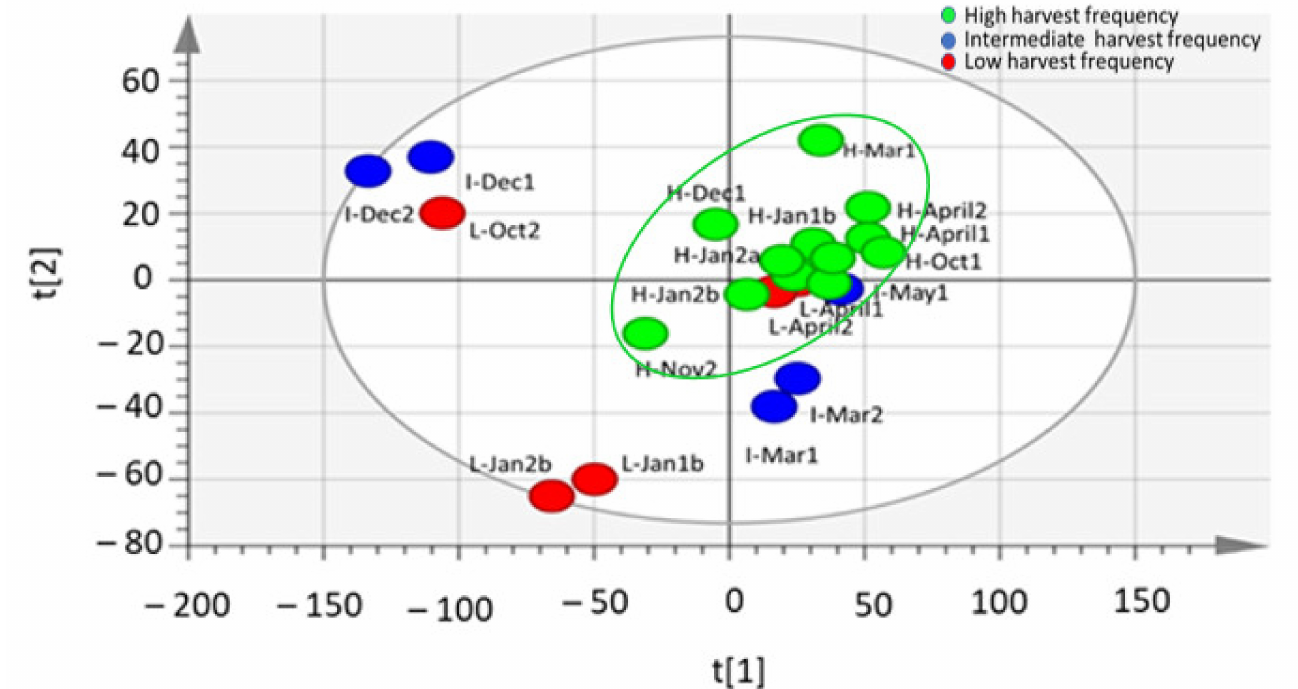
Figure 6. Partial least square (PLS) linear regression score plot showing 1 H-NMR spectral data of M. oleifera (cultivar PKM1) metabolites profile under low, intermediate, and high harvesting frequencies. Low harvest frequency (red dots), intermediate harvest frequency (blue dots), high harvest frequency (green dots). H-30 days harvesting frequency; I-60 days harvesting frequency; L-90 days harvesting frequency; Jan-a = January, A = April, Mar = March, May = May, Oct = October, Nov = November, Dec = December; Jan-b–January of the next year. R 2 X[1] = 0.488; R 2 X[2] =